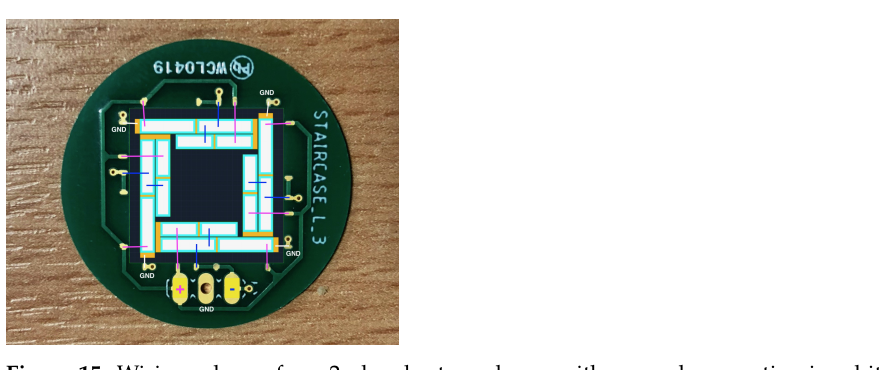
Figure 15. Wiring scheme for a 2nd-order transducer, with ground connection in white, positive polarisation voltage in magenta, and negative polarisation voltage in blue.